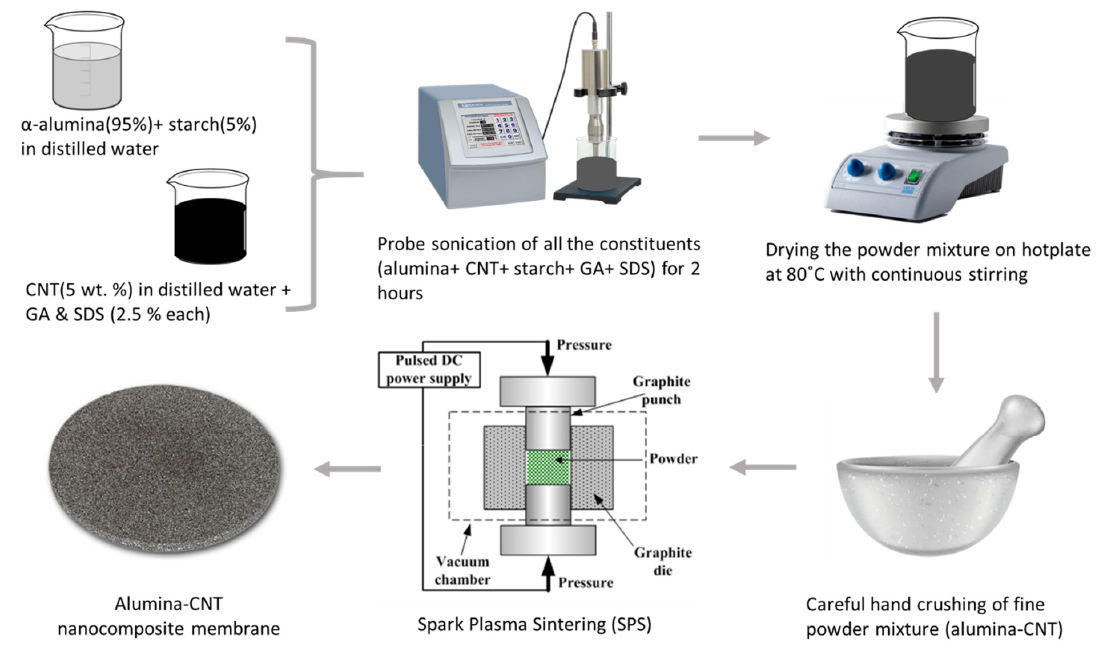
Figure 1. Approach and steps used for the preparation of alumina–carbon nanotubes (CNT) powder mixture and membrane.